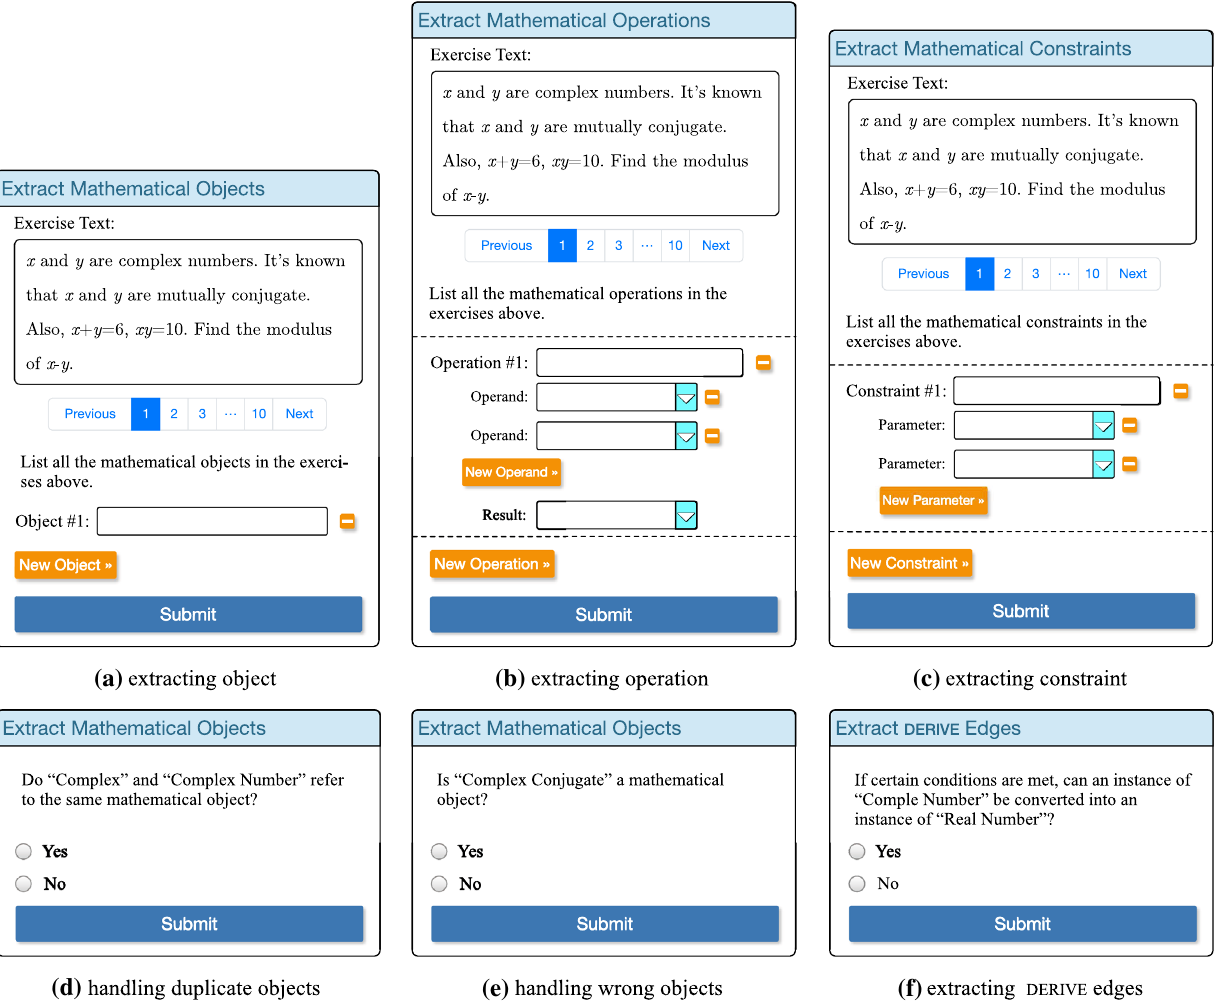
Fig. 3 User interface designed for extracting